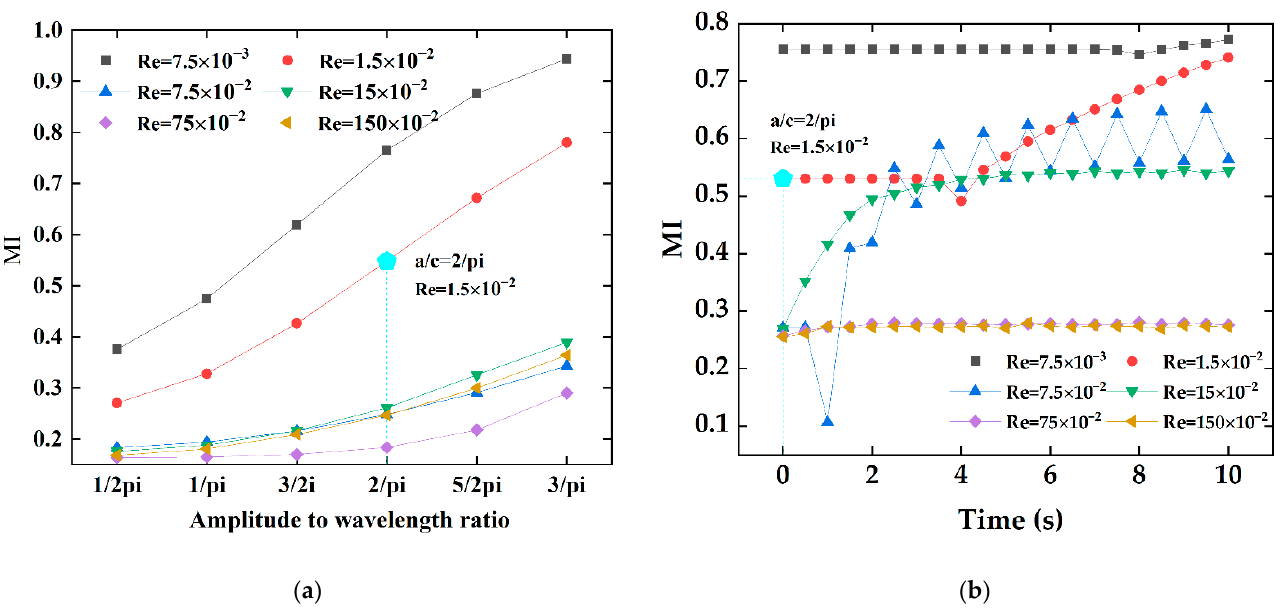
Figure 10. Variations of the mixing index at the outlet of the passive micromixer and the electroos- motic micromixer with different Reynolds numbers: ( a ) the mixing index of the passive micromixer of six amplitude of wavelength ratios, ( b ) the mixing index of the electroosmotic micromixer within 0–10